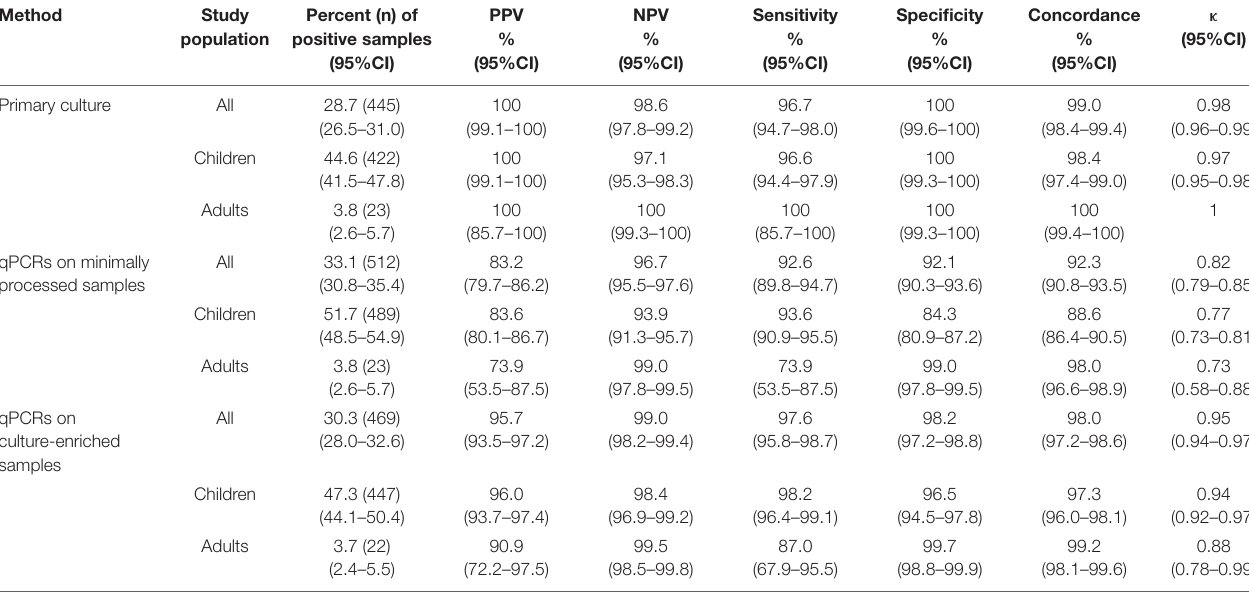
thresholds for a sample positivity in